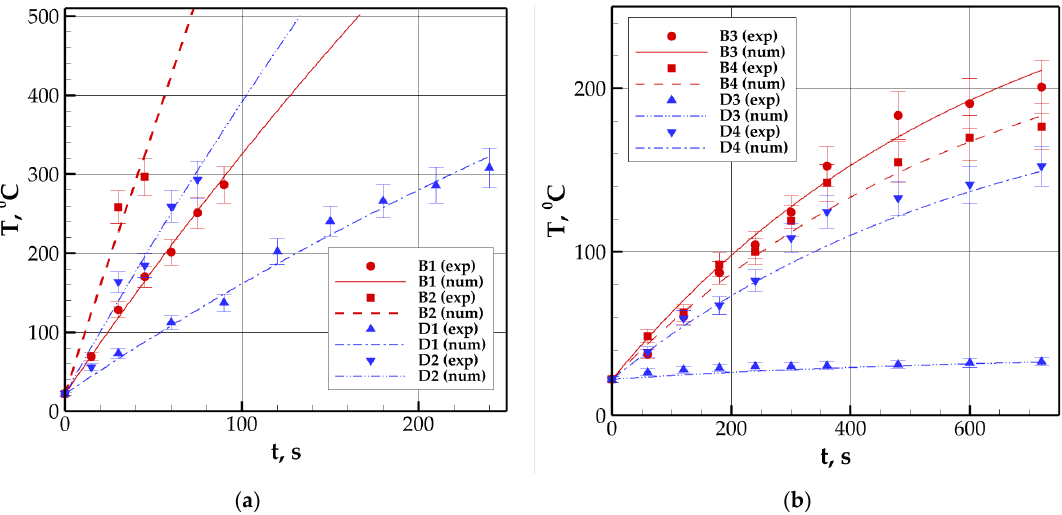
Figure 13. Comparison of the experimental data and the numerical modeling results for heating dynamics of source rock